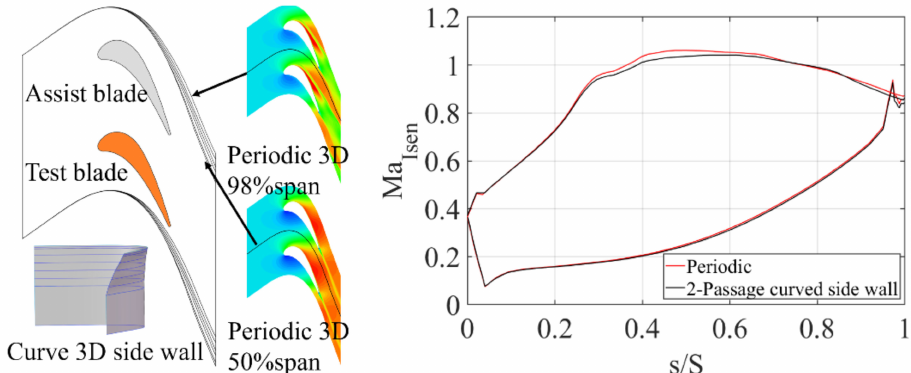
Figure 8. Isentropic Mach number distribution of test blade near tip (97% span) for Periodic case and 2-Passage curve side wall case.